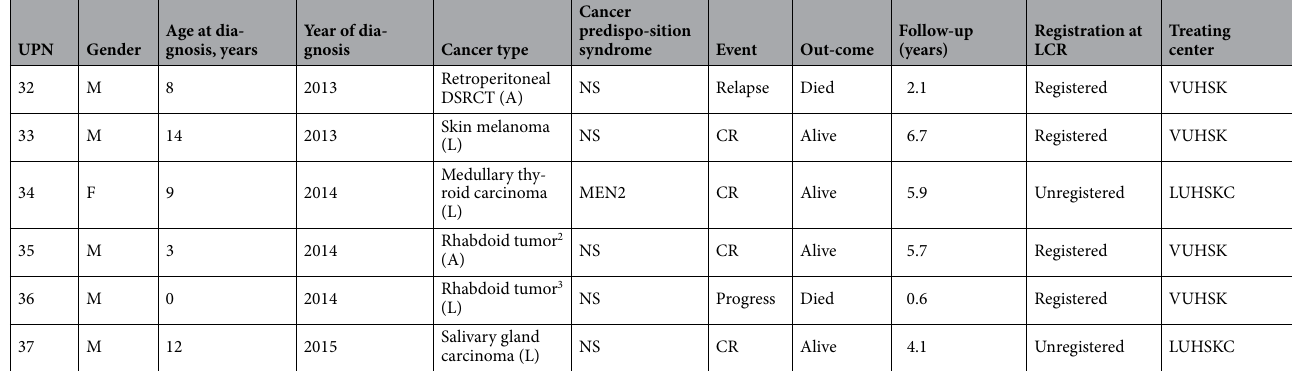
Table 1. Baseline characteristics of the study patients (n = 37). 2ndCa, the second cancer; A, advanced stage at diagnosis; CR, complete remission; DSRCT, desmoplastic small round cell tumor; F, female; L, local disease at diagnosis; LUHSKC, Lithuanian University of Health Sciences Kaunas Clinics; M, male; MEN2, multiple endocrine neoplasia type 2; NS, not specified; TRM, treatment related mortality; UPN, unique patient number in the study; VHL, von Hippel Lindau syndrome; VUHSK, Vilnius University Hospital Santaros Klinikos. 1 Rhabdoid tumor of the thoracic wall. 2 Rhabdoid tumor of multiple supradiaphragmatic lymph nodes and lung metastases. 3 Rhabdoid tumor of right axillar soft tissue.